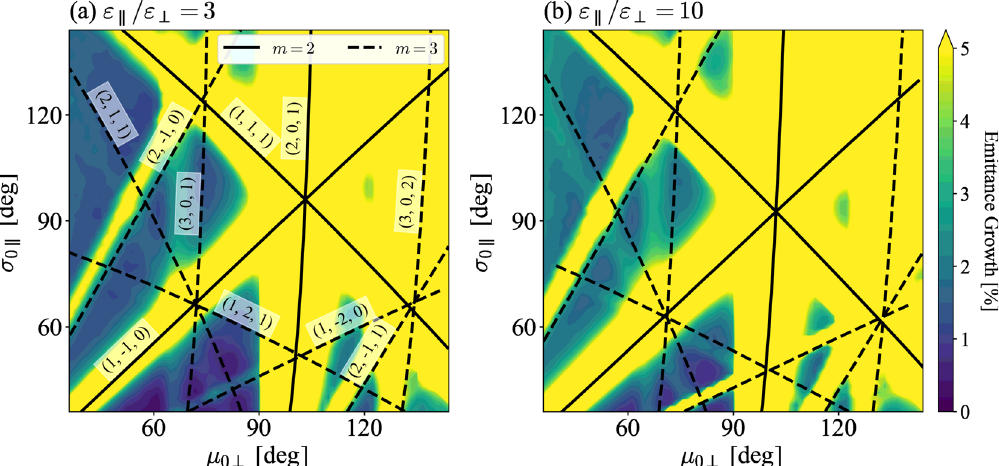
FIG. 8. W ARP simulation results obtained with nonequipartitioned beams. The initial distribution is the Gaussian type that has the rms emittance ratio of (a) ε k = ε ⊥ ¼ 3 and (b) ε k = ε ⊥ ¼ 10 . The bunch intensity and all projected emittances at injection are fixed over the whole tune space. The color is chosen based on largest emittance growth of the three directions at the exit of the 100th AG cell. The solid and dashed lines are obtained from Eq. (6) for m ¼ 2 and 3. Three numbers in the left picture represent ð n ⊥ ; n k ; n 0 Þ